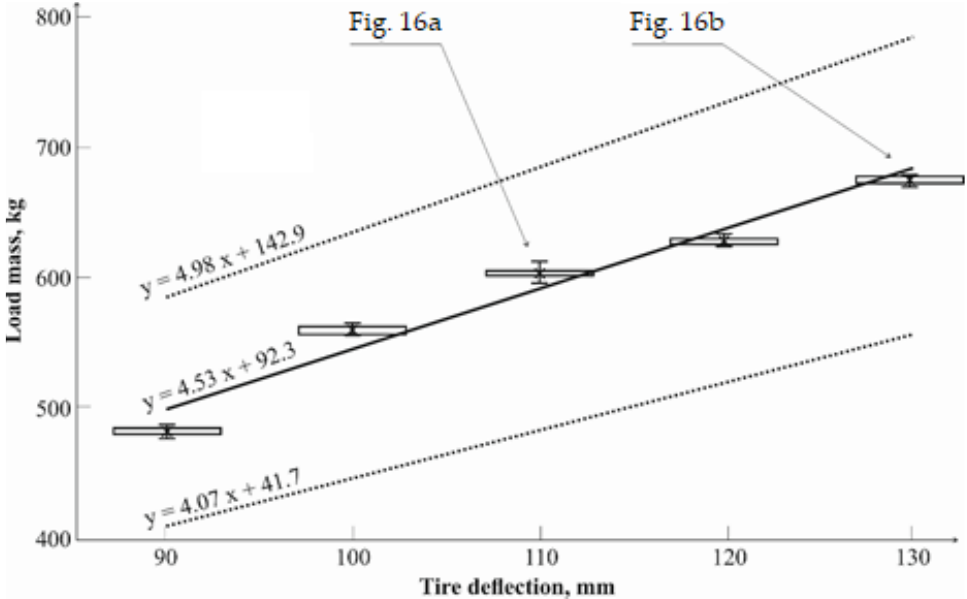
Figure 15. Results of testing load mass for particular deformation of tire up to contact of the “belt” with ground.